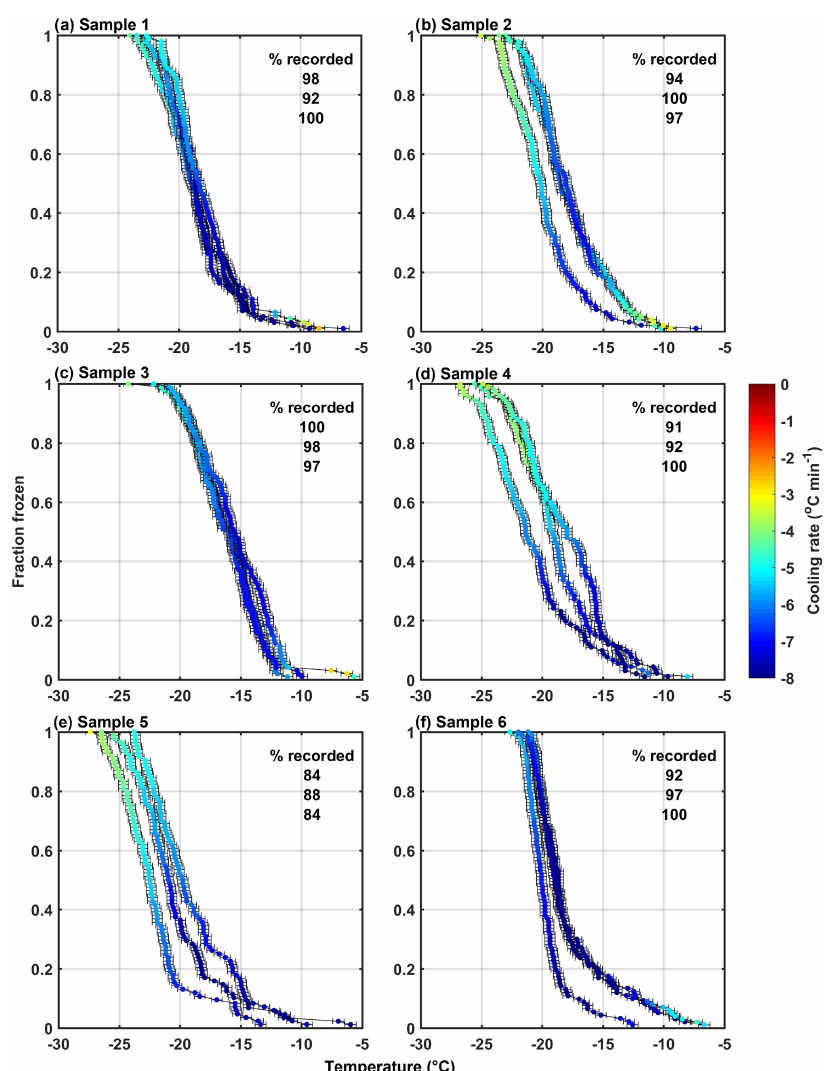
Figure 6. Freezing spectra for the three tests of each of the samples collected from HOVERCAT during the 25 May 2017 test flight. Each data point is colored by cooling rate and has error bars associated with Omega ™ temperature probe uncertainty. The percentage of recorded frozen drops is provided for each